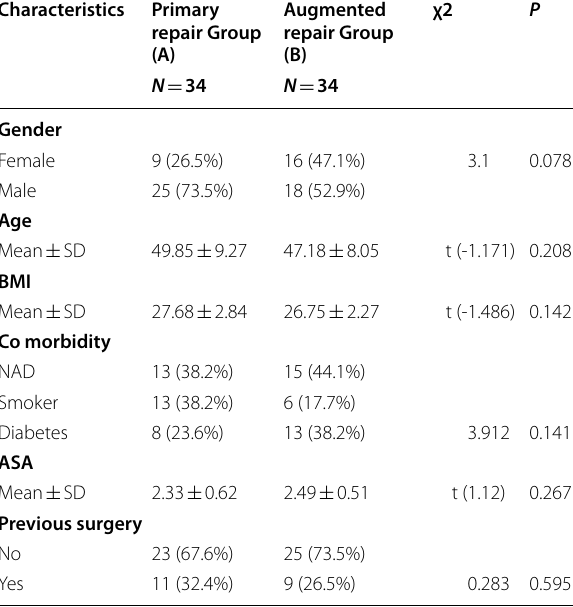
Z Mann Whitney test t independent sample t-test p > 0.05 is statistically non- significant